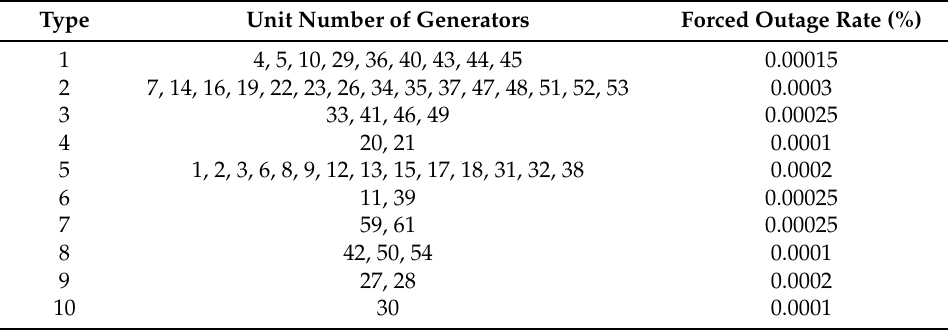
Table 1. Forced Outage Rate (FOR) for the 54 generators in the IEEE 118 bus system.